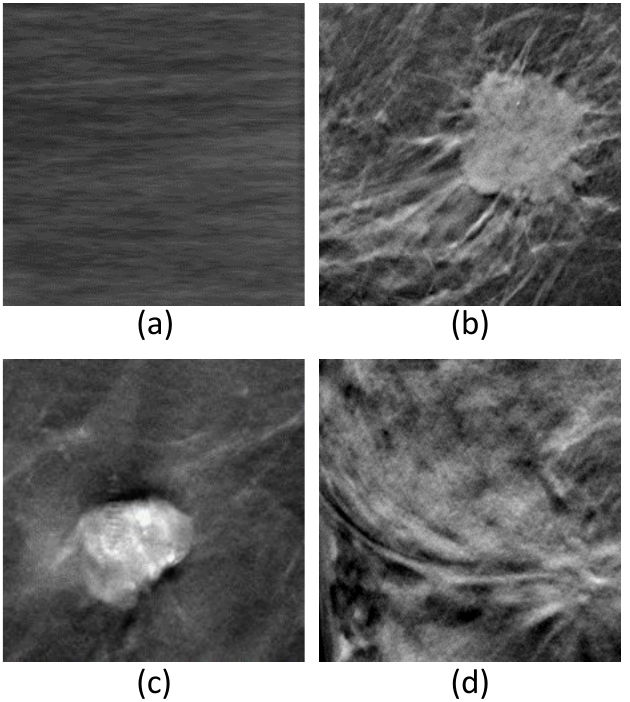
Figure 4. The ready-to-classify RoIs on the images. ( a ) Example of image with no lesions (None); ( b ) example of image with irregular opacity (Ori); ( c ) example of image with regular opacity (Oro); and ( d ) example of image with stellar opacity